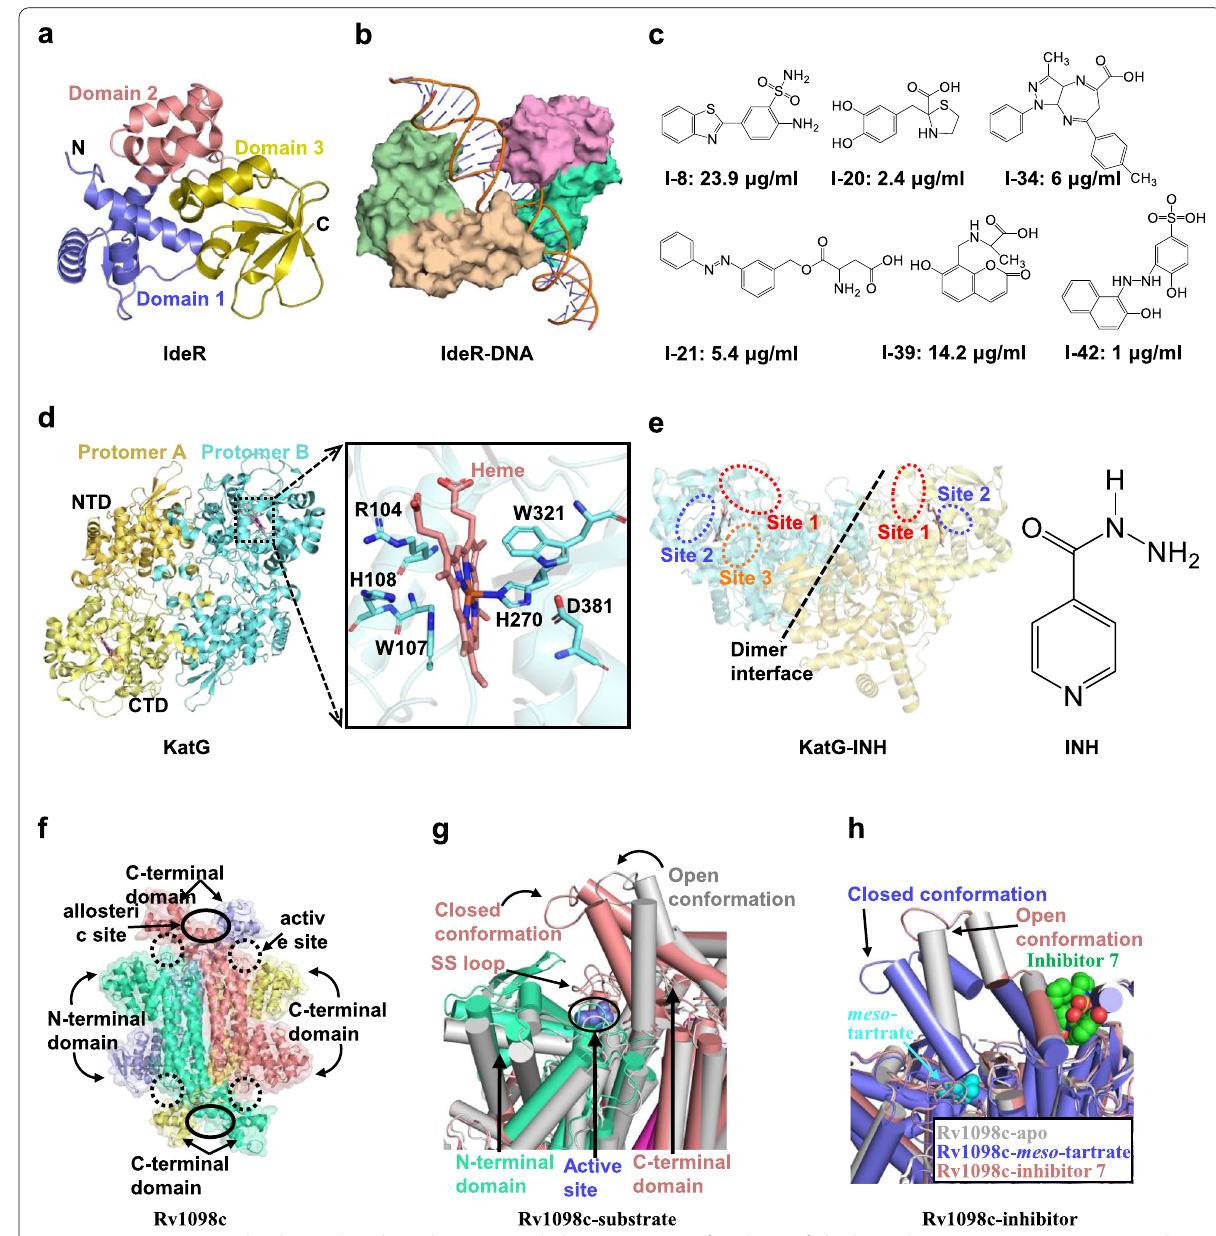
Fig. 6 Enzymes associated with metal uptake and energy metabolism. a Structure of a subunit of IdeR homodimer (PDB ID: 1FX7). Domain 1, the N-terminal DNA-binding winged helix-turn-helix (wHTH) motif; domain 2, the dimerization domain; domain 3, the C-terminal SH3-like domain. b Structure of DNA- binding IdeR (PDB ID: 2ISZ). c Structure of small molecules potentially inhibiting IdeR activity and their respective IC50 values. d Structure of catalase-peroxidase (KatG) homodimer in a complex with heme (PDB ID: 2CCA). The heme is surrounded by six conserved residues, among which Arg104, Trp107, and His108 in a pocket distal to the heme, and His270, Trp321, and Asp381 in a pocket proximal to the heme. e Sites of INH binding to KatG (Left) and a chemical structure of isoniazid (INH, Right). The anti- tuberculosis pro-drug INH is required to be activated to form a bactericidal molecule (IN-NAD adduct) by KatG, and then targets the enoyl-acyl carrier protein reductase (InhA), which is responsible + for biosynthesis of cell wall component mycolic acid. f Overall structure of the homotetrameric fumarate hydratase (Rv1098c, PDB ID: 4APA)). The dashed circles indicate the location of the four active sites, and the solid circles indicate the location of the two allosteric sites. g A depiction of Rv1098c active site when formate or L-malate (slate spheres) is bound. Apo-Rv1098c is shown in gray, while the N- and C-terminus of substrate (formate or L-malate)-bound Rv1098c are shown in greencyan and pink, respectively. Upon binding of formate or L-malate, the C-terminal domain of the subunit (purple) rotates into the closed conformation. h Superposition of apo (gray, PDB ID: 4APA), meso-tartrate-bound (slate, PDB ID: 4ADM) and inhibitor 7-bound (pink, PDB ID: 5F91) Rv1098c. Binding of meso-tartrate causes the active site of Rv1098c to be occupied, whereas binding of inhibitor 7 causes the C-terminus of the subunit to rotate into the open